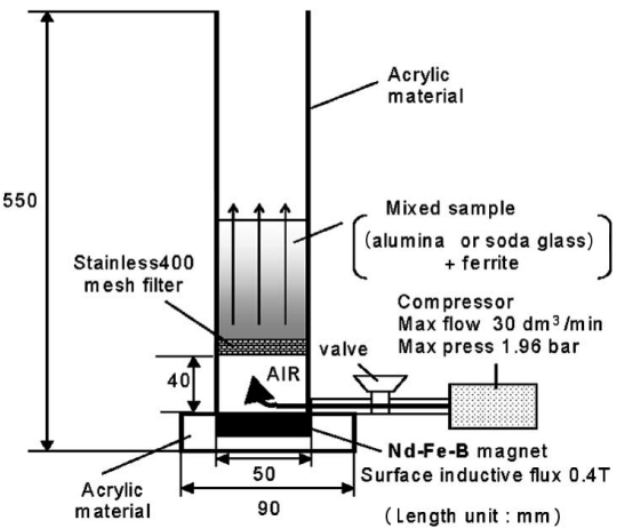
Figure 9. Equipment for magnetic separation in dry process [44].